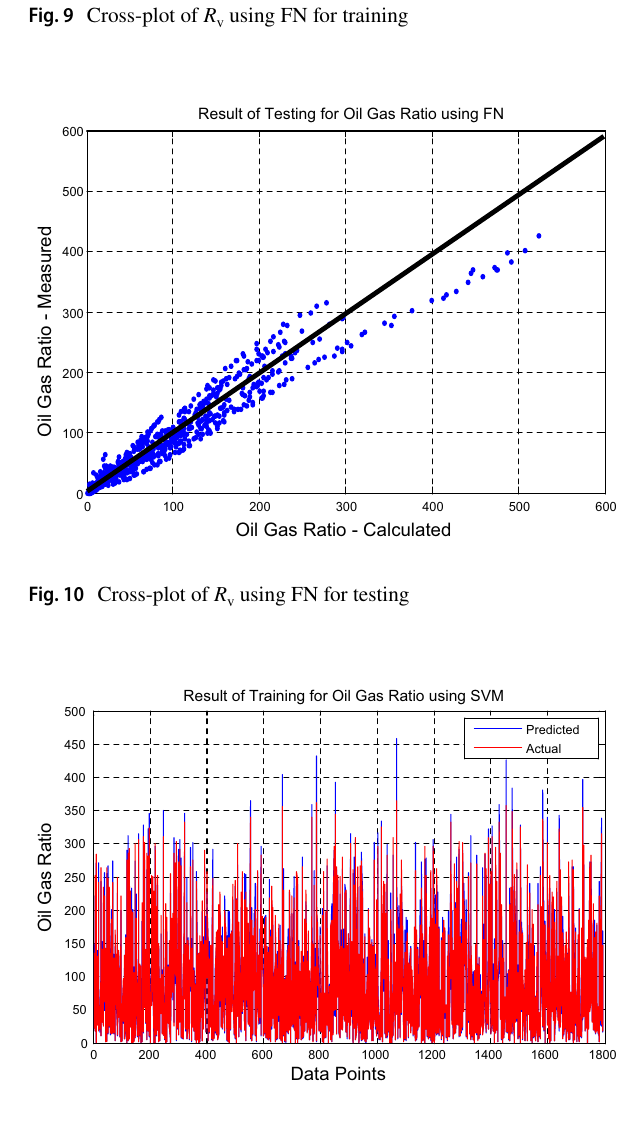
Fig. 11 Predicted and actual R SVM for training